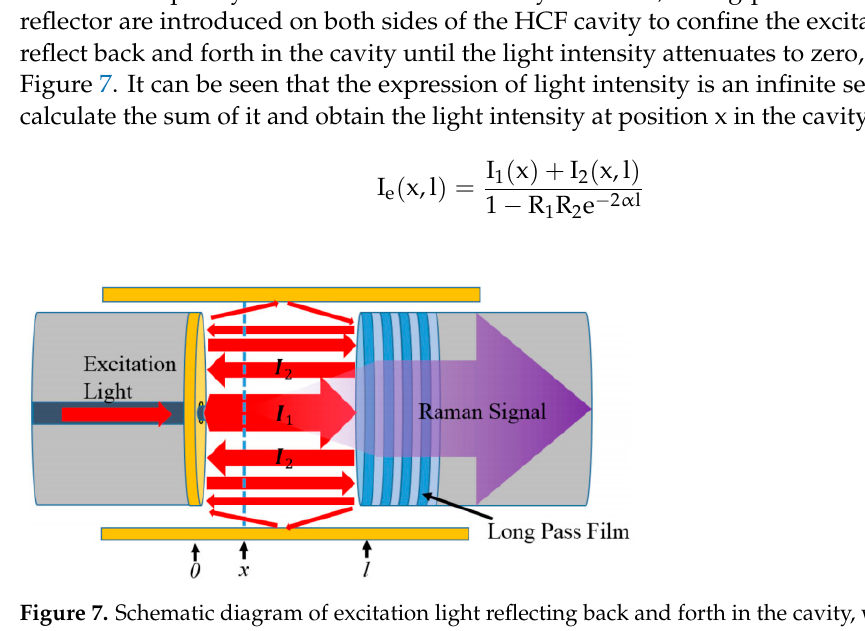
light intensity is their scalar summation. Reprinted with permission from [46] © The Optical Society.